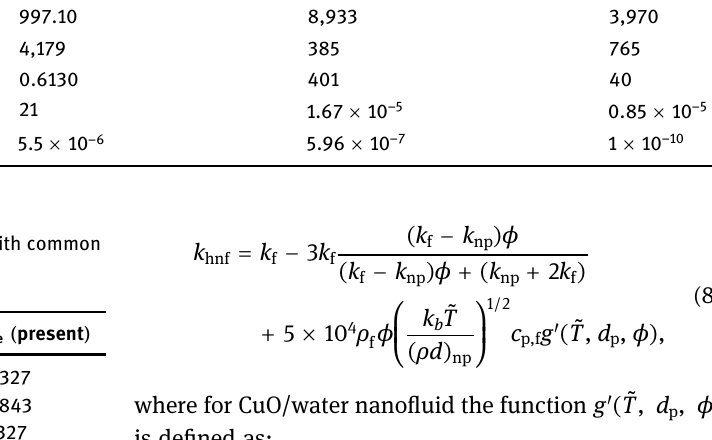
Properties Water